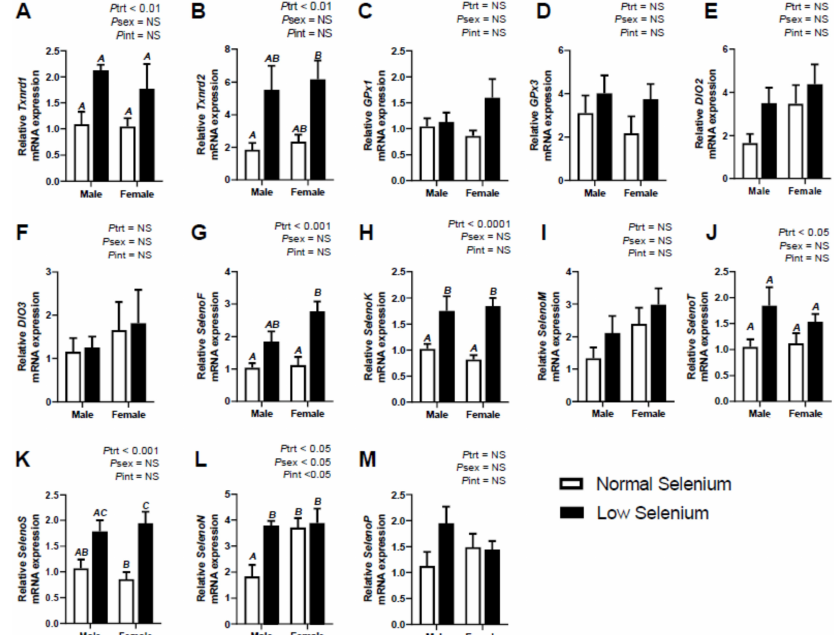
Figure 3. E ff ects of selenium deficiency on selenoprotein expression in fetal hearts at E18.5. Expression in male and female fetal hearts, at E18.5, of; ( A ) thioredoxin reductase 1, ( B ) thioredoxin reductase 2, ( C ) glutathione peroxidase 1, ( D ) glutathione peroxidase 3, ( E ) deiodinase 1, ( F ) deiodinase 3, ( G ) selenoprotein F, ( H ) selenoprotein K, ( I ) selenoprotein M, ( J ) selenoprotein T, ( K ) selenoprotein S, ( L ) selenoprotein N and ( M ) selenoprotein P. Data are mean ± SEM and analysed by two-way ANOVA with treatment ( P trt ) and sex ( P sex ) as major factors. P int represents the interaction between treatment and sex. Significance was determined as p < 0.05. If a major e ff ect of treatment, sex or an interaction between treatment and sex was identified, then a Sidak posthoc test was performed. Significant di ff erences between groups as detected by posthoc analysis are denoted by di ff erent letters where “A” is di ff erent from “B” which is di ff erent from “C”. “A” is not di ff erent from “A”, “AB” or “AC”, while “B” is not di ff erent from “B”, or “AB”. The groups are Normal male, n = 6 (6 animals from 6 separate litters); Low male, n = 6 (from 6 separate litters); Normal female, n = 6 (from 6 separate litters); Low female, n = 6 (from 6 separate